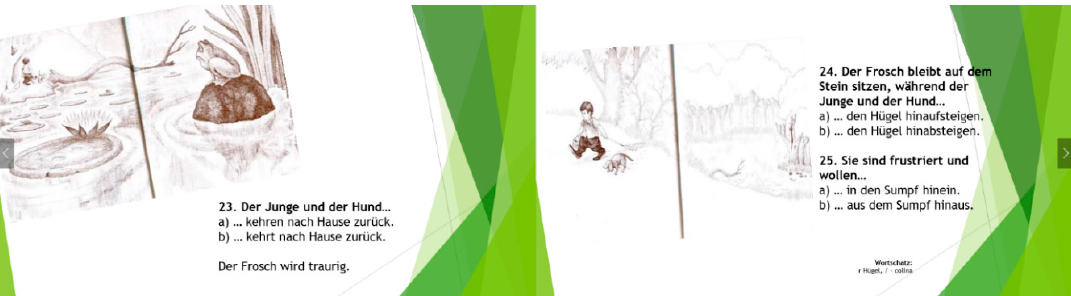
Figure A22. Pretest: Binary-choice recognition task.